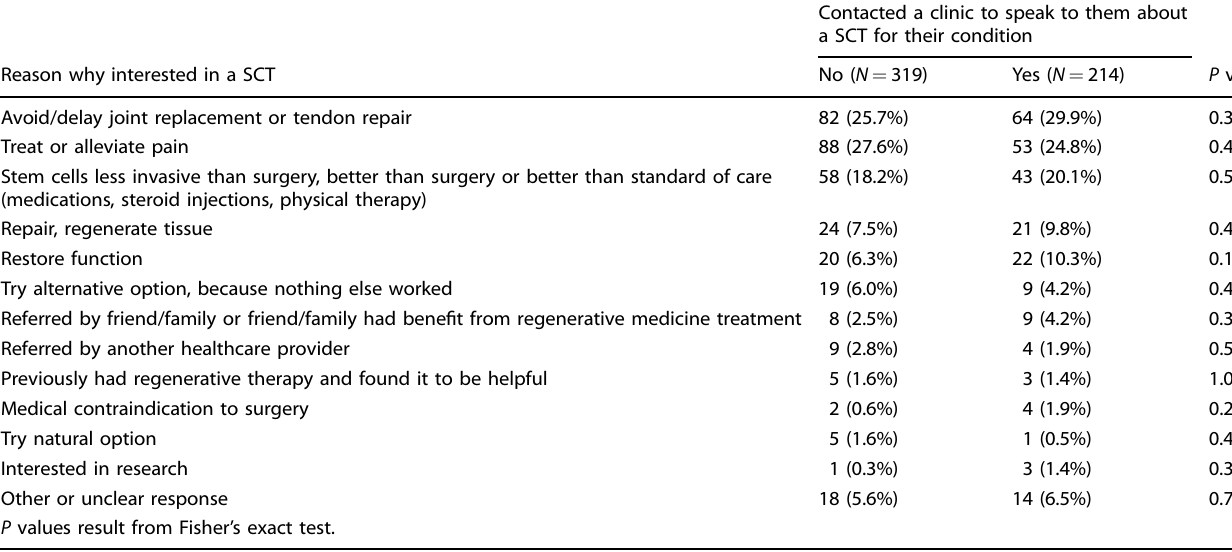
Table 5. Comparison of reasons why patients reported that they were interested in a SCT for their condition according to whether they had contacted a clinic to speak to them about a SCT for their